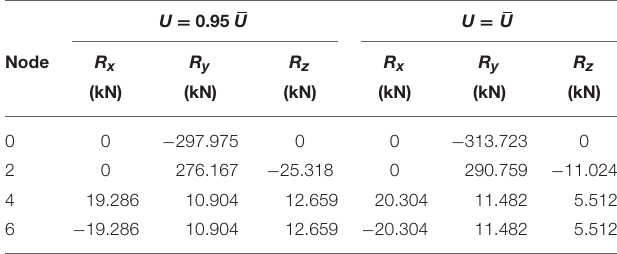
TABLE 4 | Nodal forces acting in the almost fully-flat ( U U ) configurations. ( U =